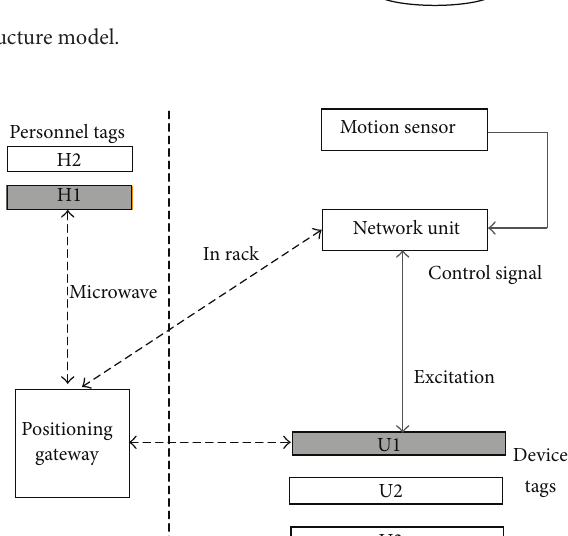
Figure 2: System structure model.